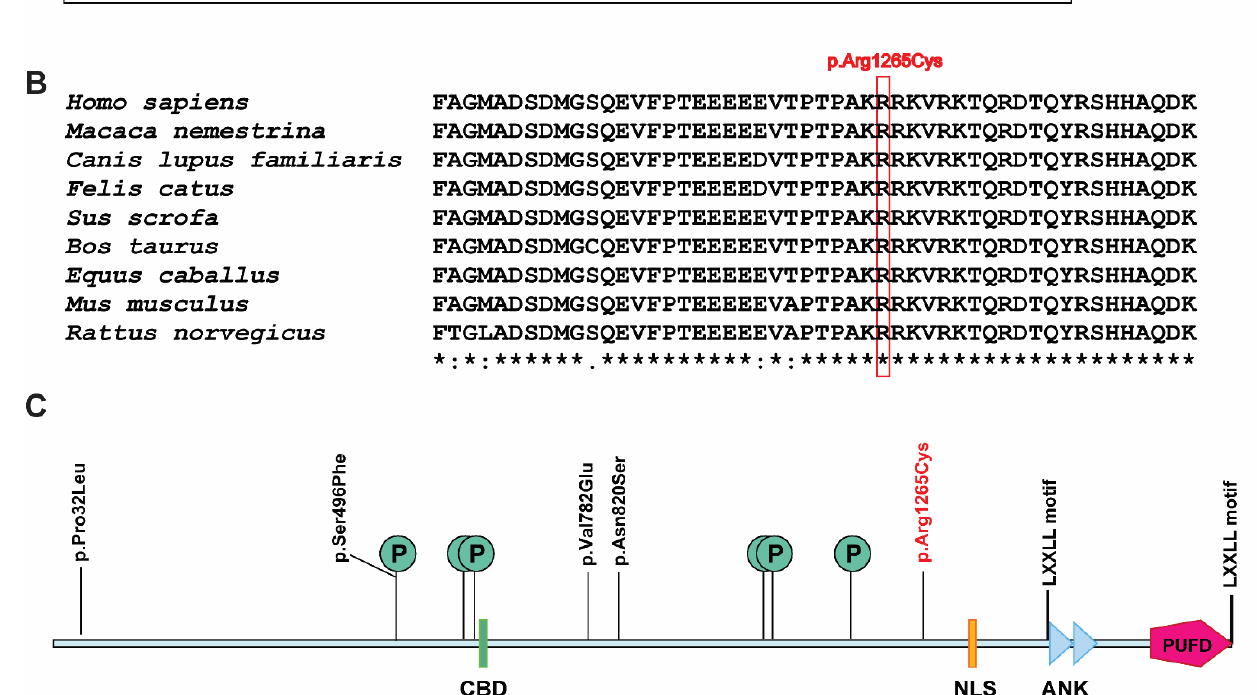
Figure 2. BCORL1 pathogenic variant. ( A ) Sanger sequencing results of BCORL1 gene variant g.129159069C>T in two affected individuals (hemizygous) and the unaffected father (heterozygous). The site of the pathogenic variant is marked by a red arrow. ( B ) Conservation of the region with the novel pathogenic variant across species. The mutated amino acid is enclosed in a red rectangular box (p.Arg1265Cys). ( C ) Depiction of domains, motifs, phosphorylation sites (indicated by “P” within a circle), and pathogenic variants in BCORL1 protein. The novel pathogenic variant reported in this study is marked in red.